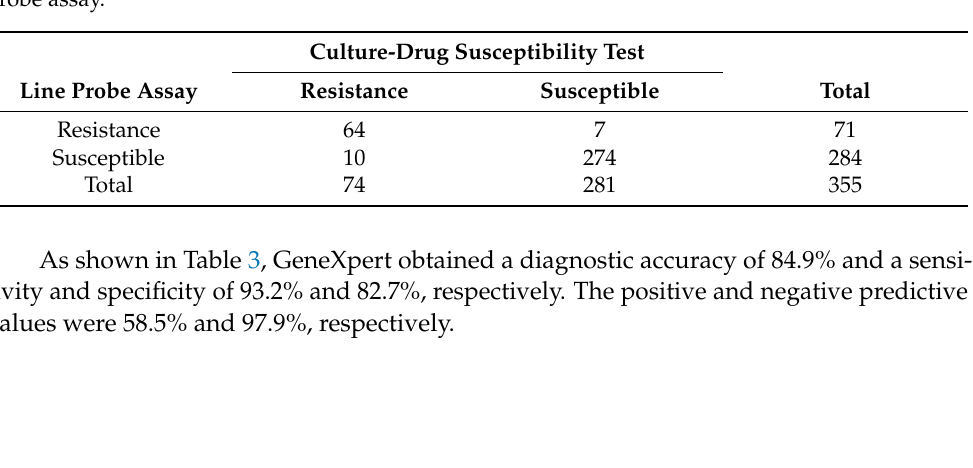
Table 2. Comparison of rifampicin resistance results of conventional culture method versus line probe